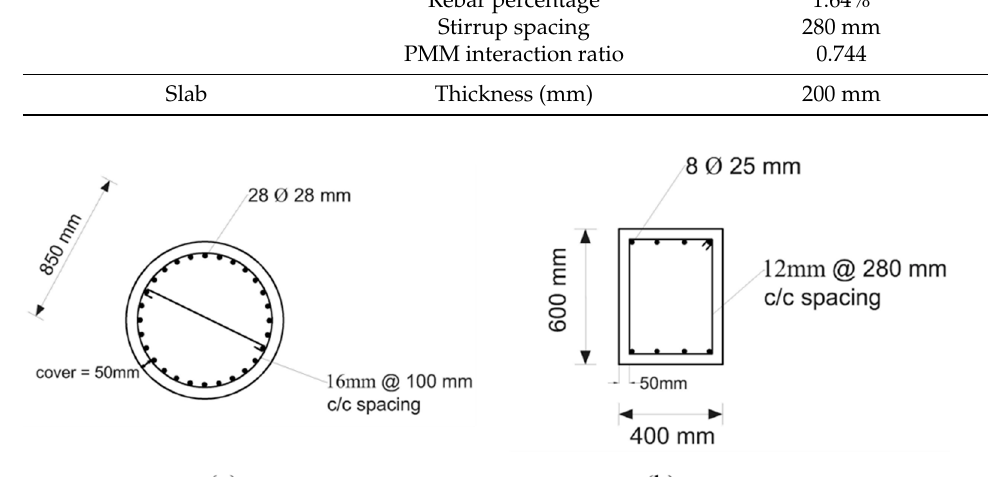
Figure 2. Proposed building ( a ) three-dimensional, ( b ) plan, and ( c ) elevation view.